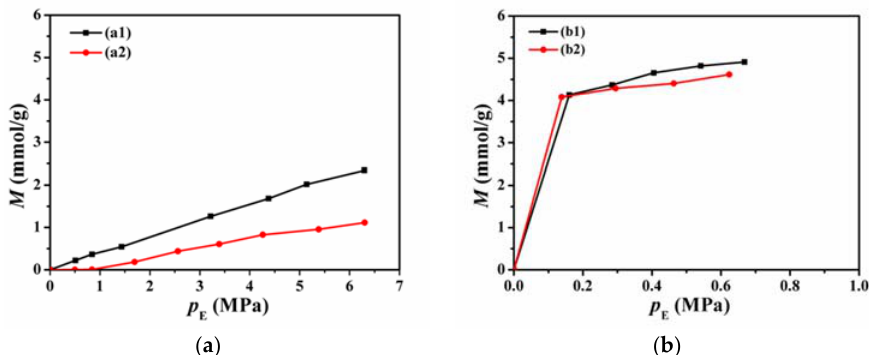
Figure 2. Adsorption isotherms of different pure gases (H 2 , C 3 H 6 ) with different zeolitic imidazolate framework-8 (ZIF-8) conditions at 293 K: ( a ) (H 2 ), ( b ) (C 3 H 6 ), b1 (with solid ZIF-8) and b2 (with a ZIF-8 slurry, which was suspended in water with a mass concentration of 15 wt %).